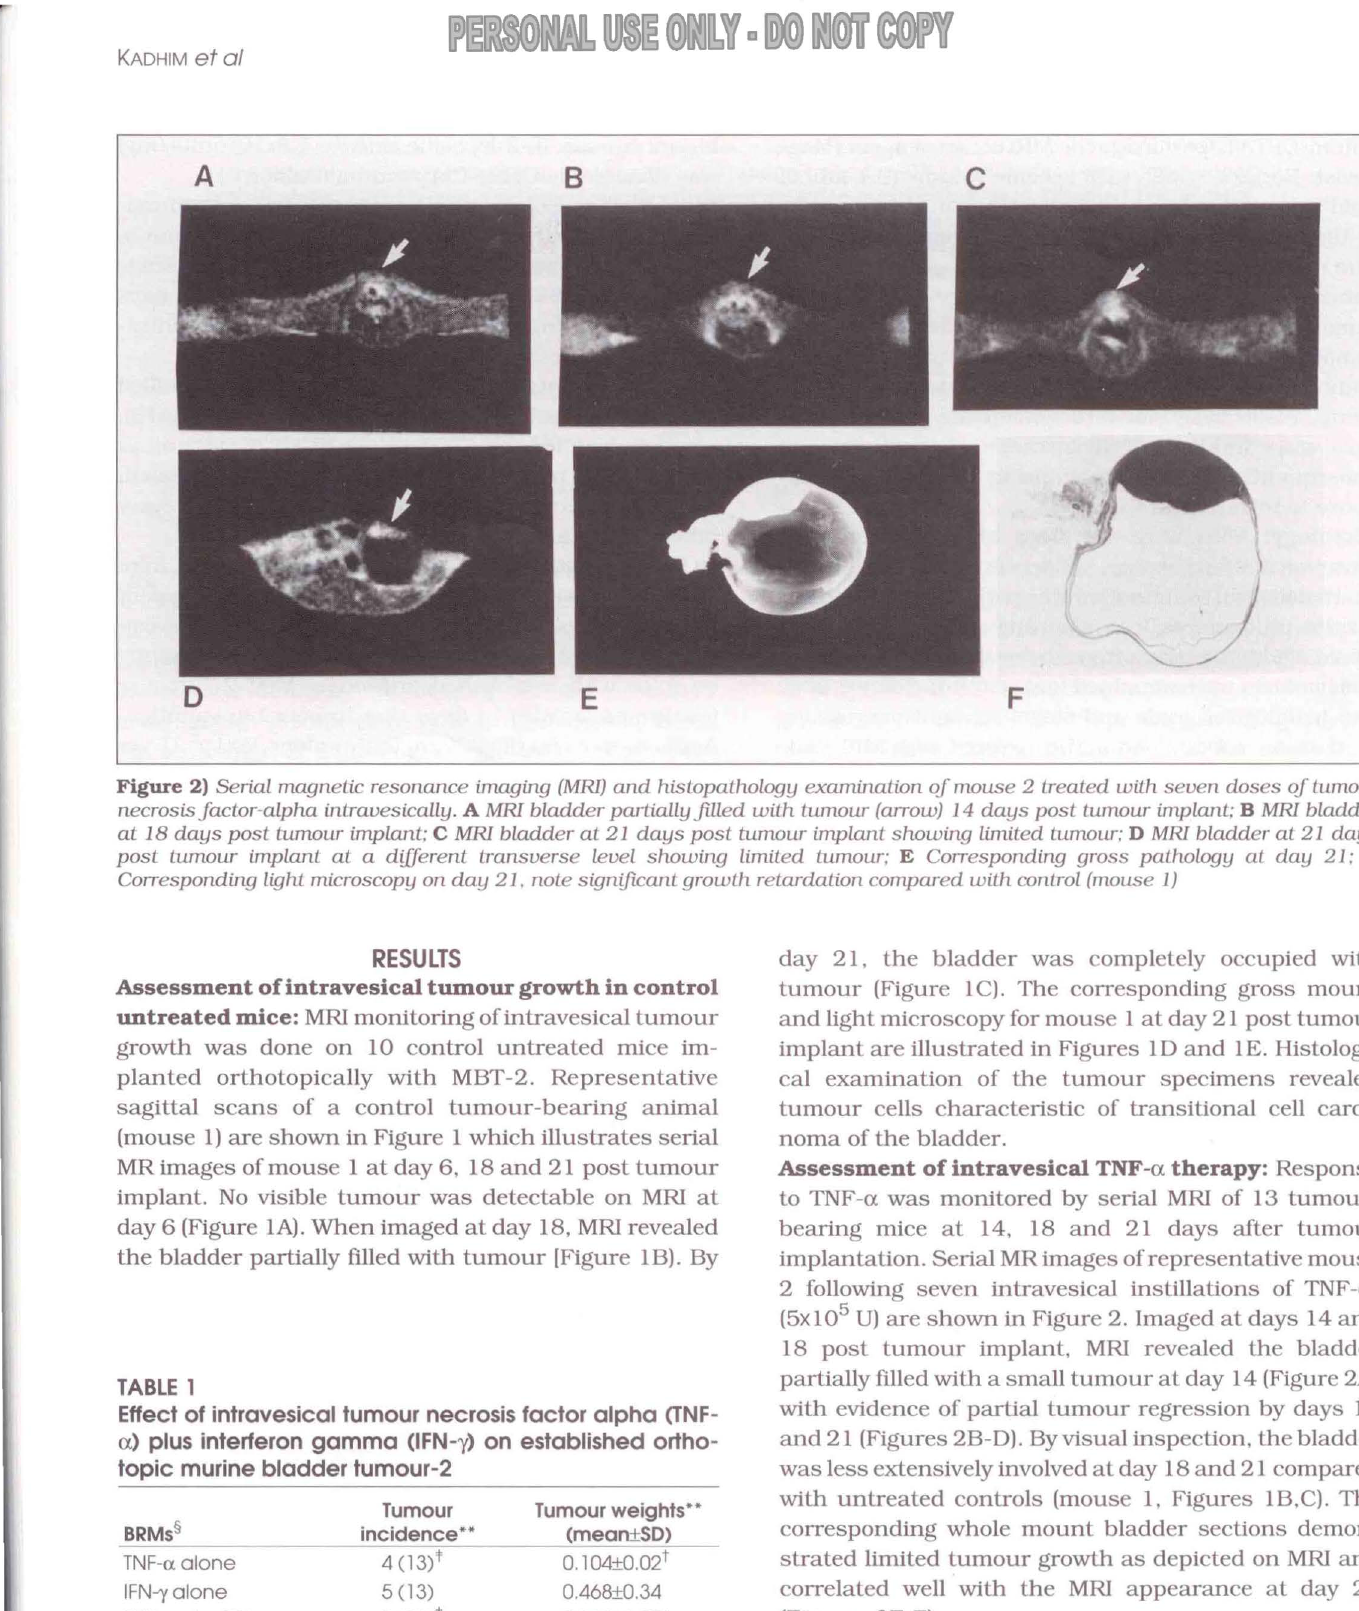
Effect of intravesical tumour necrosis factor alpha (TNF a) plus interferon gamma (IFN-y) on established